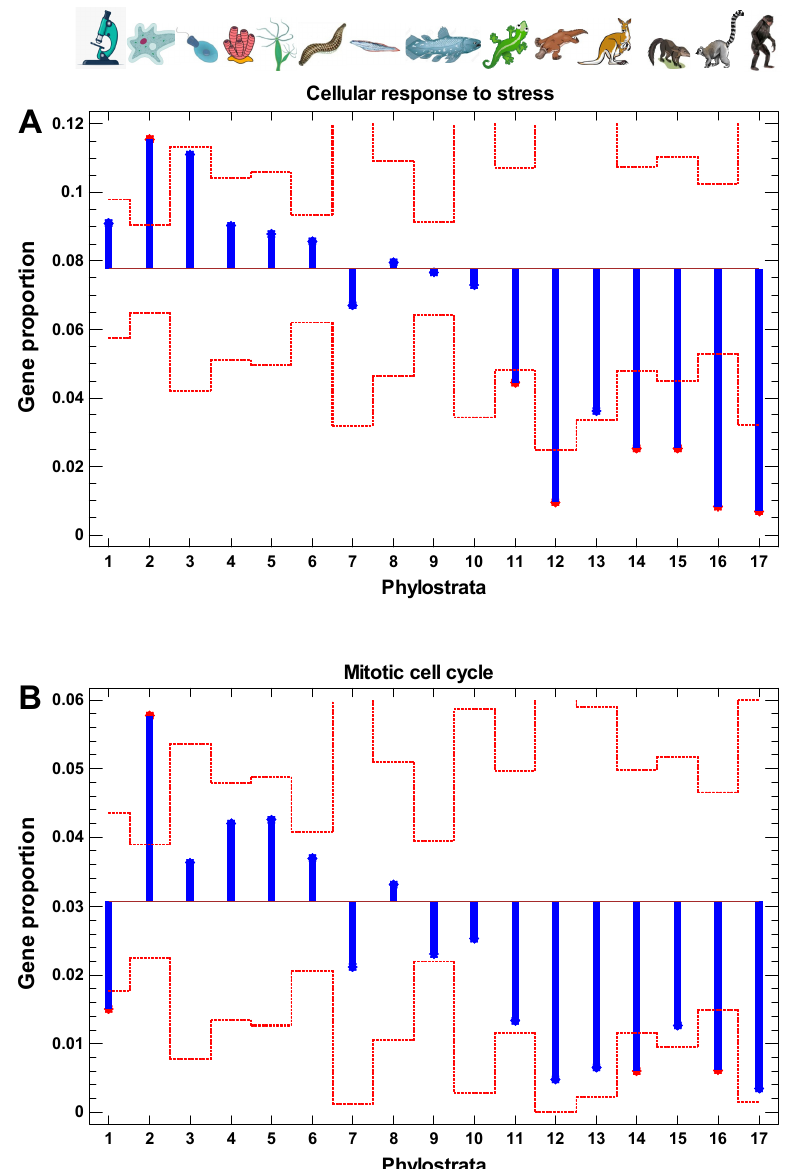
Figure 10. The evolutionary profile of genes belonging to GO Biological Processes: ( A ) ‘cellular response to stress’ (GO:0033554); ( B ) ‘mitotic cell cycle’ (GO:0000278). Red dotted lines show con-fidence intervals for individual phylostrata ( p = 0.05). For all phylostrata taken as points, Spearman rank correlation between gene proportion and phylostrata: r = − 0.96, p < 0.0001 ( A ); r = − 0.82, p < 0.001 ( B ). Phylostrata: 1—cellular organisms (Prokaryota); 2—Eukaryota; 3—Opisthokonta; 4—Metazoa;